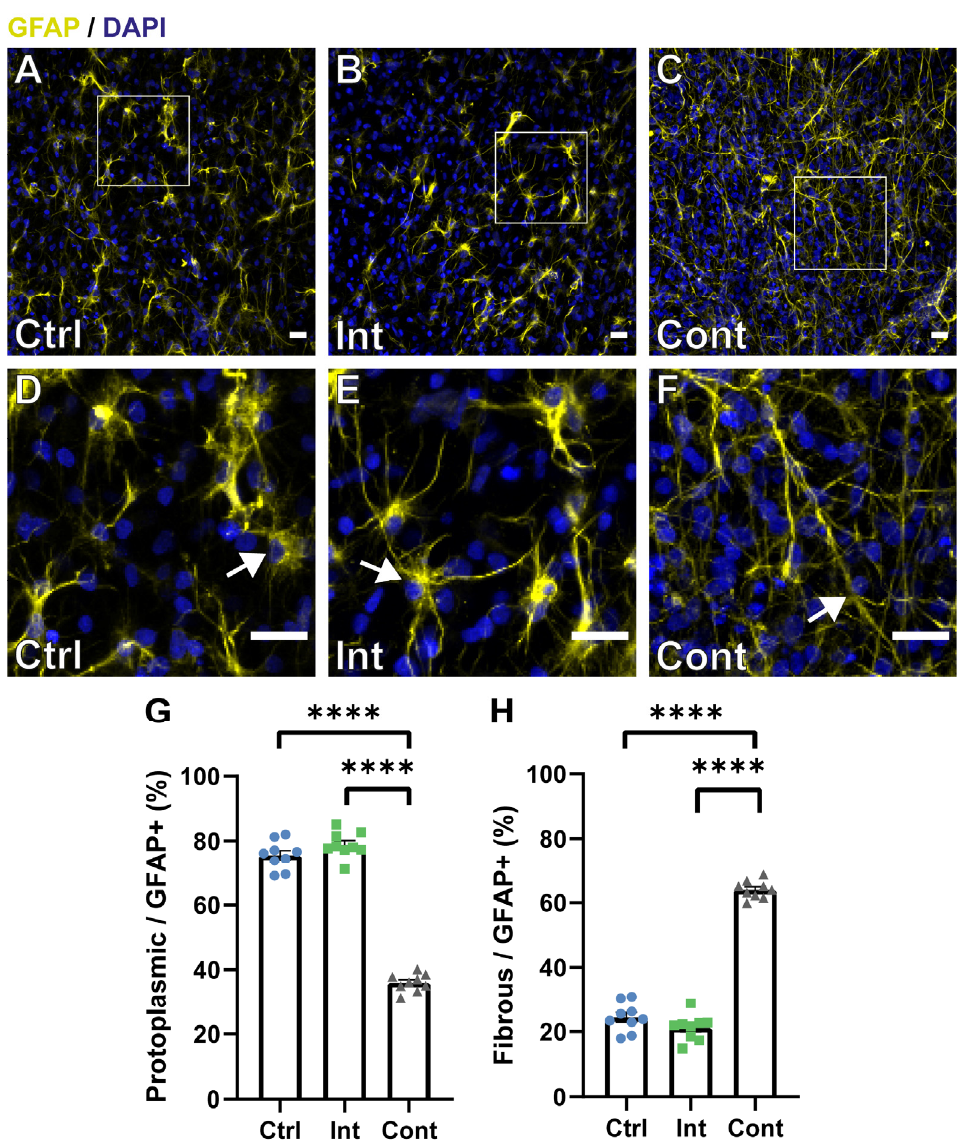
Figure 4. ( A – C ): Representative images of immunocytochemistry staining for GFAP (yellow) and DAPI (blue) of the control ( A ), intermittent stimulation ( B ), and continuous stimulation ( C ) groups. White squares indicate the shown magnifications ( D – F ). ( D – F ): Magnifications of the control ( D ), intermittent stimulation ( E ), and continuous stimulation ( F ) groups. White arrows indicate the group characteristic astrocyte morphology, showing protoplasmic ( D , E ) and fibrous ( F ) astrocytes. Scale bars: 20 µ m. ( G , H ): Quantification analysis of the protoplasmic ( G ) and fibrous ( H ) astrocyte ratio in the control (Ctrl), intermittent stimulation (Int), and continuous stimulation (Cont) groups. ( G ) Protoplasmic astrocyte ratio quantification (protoplasmic astrocytes/ GFAP -positive cells) (Ctrl: 75.6 ± 1.5%; Int: 78.8 ± 1.34%; Cont: 36 ± 0.9%). ( H ) Protoplasmic astrocyte ratio quantification (fibrous astrocytes/ GFAP -positive cells) (Ctrl: 24.5 ± 1.5%; Int: 21.2 ± 1.3%; Cont: 64 ± 0.8%). Data are expressed as mean ± SEM. **** p < 0.0001. Statistical differences tested by a nested one-way